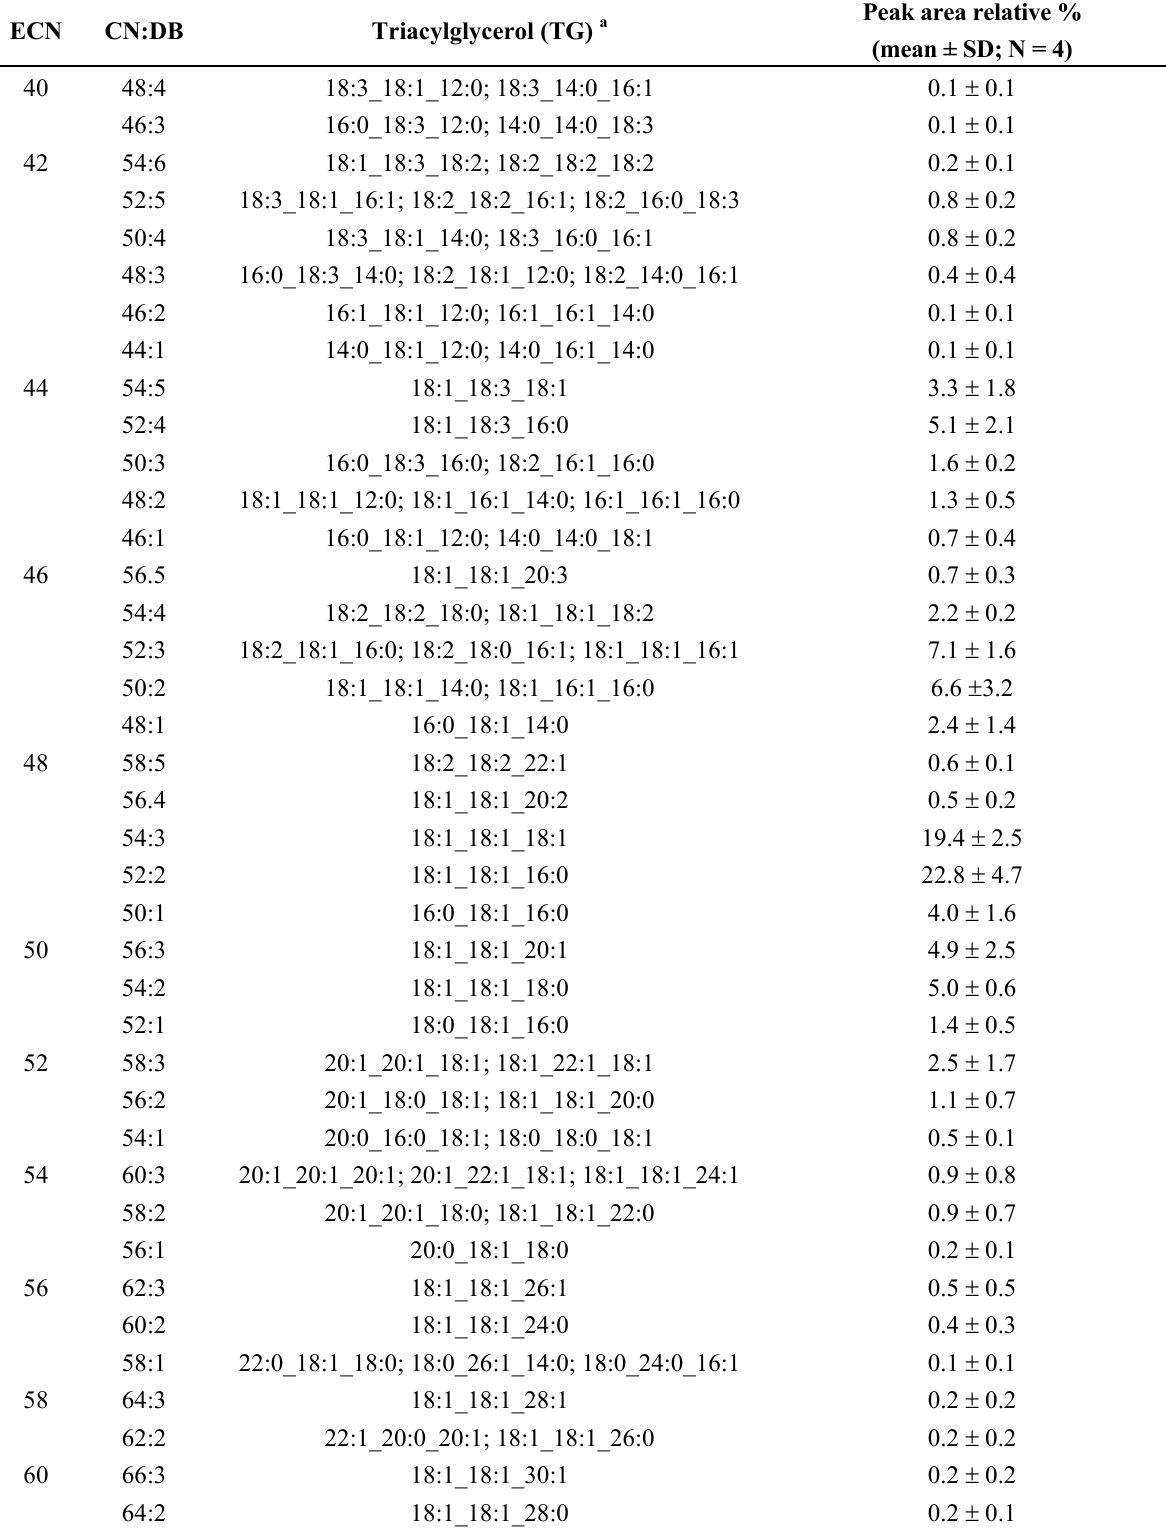
a Shorthand notation of TGs according to Liebisch and co-workers [34]. The most likely FA in the sn -2 position of the glycerol is presented as second acid in the notation